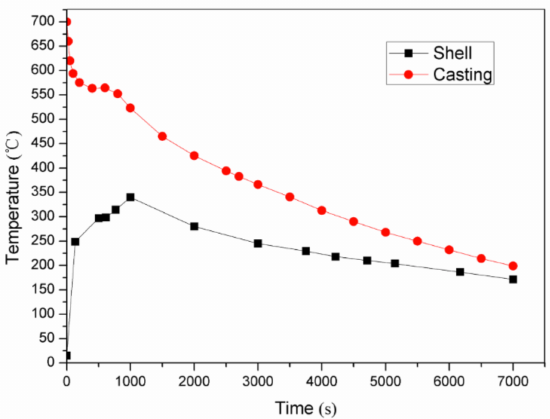
Figure 10. Cooling curves of the lattice-reinforced shell sand mold casting under natural conditions.